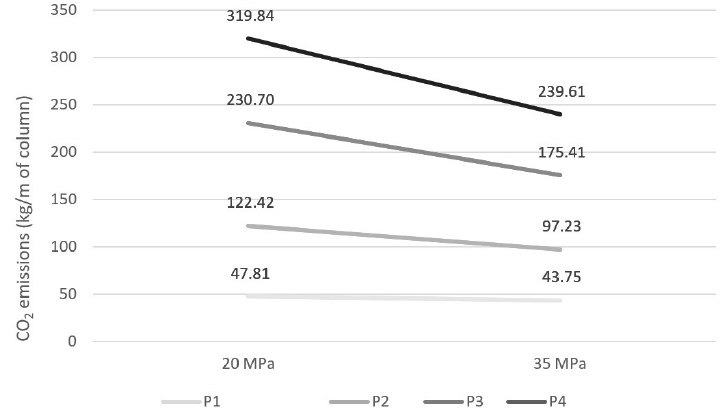
Figure 7. CO 2 emissions of the optimized design of reinforced concrete columns.